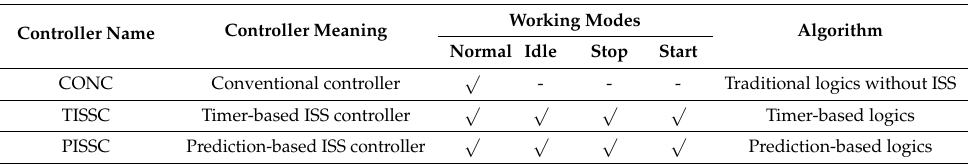
Table 3. Functionalities of comparative ICE speed